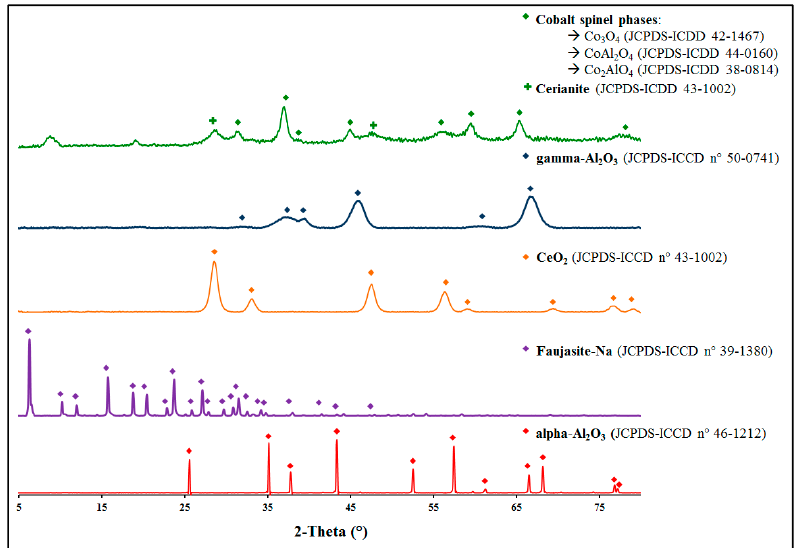
Figure 1. X ‐ ray diffraction patterns of the catalysts.